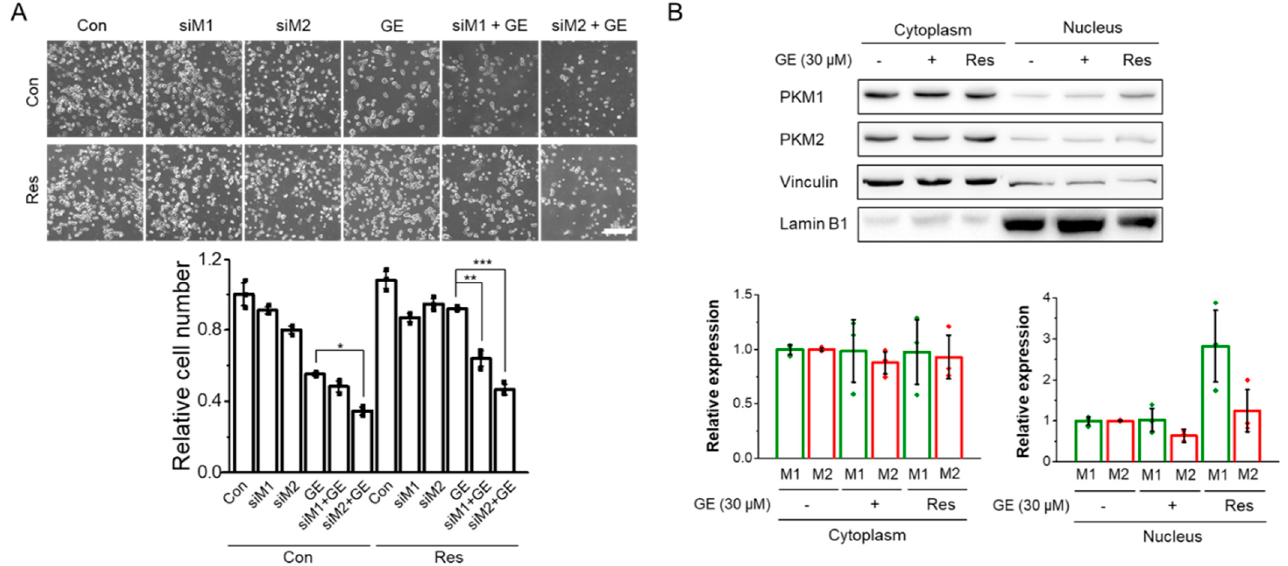
Figure 5. The importance of PKM isoforms in the acquisition of drug resistance. ( A ) The effect of PKM isoform depletion on the response to GE. Control or GE-resistant HCT116 cells (Con or GE Res) were pretreated with the appropriate siRNAs (siM1 and siM2) for 24 h and exposed to GE (30 µ M) for 24 h. The viable cells were counted in three independent experiments as described in the Materials and Methods section. Data are shown as average ± SD of three independent experiments. Scale bar, 300 µ m. ( B ) Expression of PKM proteins upon GE treatment in nuclear and cytoplasmic fractions. Individual fractions were normalized by vinculin (cytoplasmic extract) and Lamin B1 (nuclear extract). Data are shown as average ± SD of three independent experiments. * p < 0.05, ** p < 0.01, and *** p <